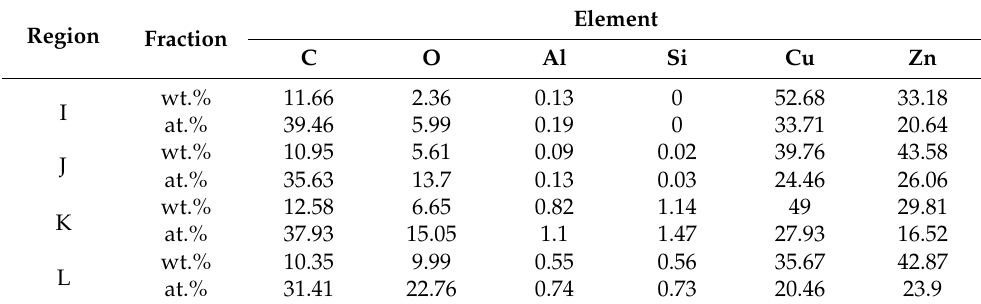
Table 9. Chemical composition of the wire electrode. Region Fraction